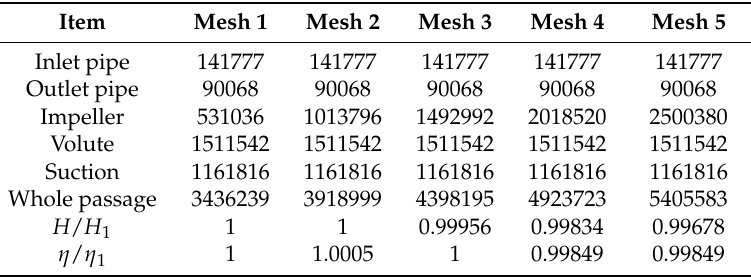
Table 2. Mesh sizes for mesh independency